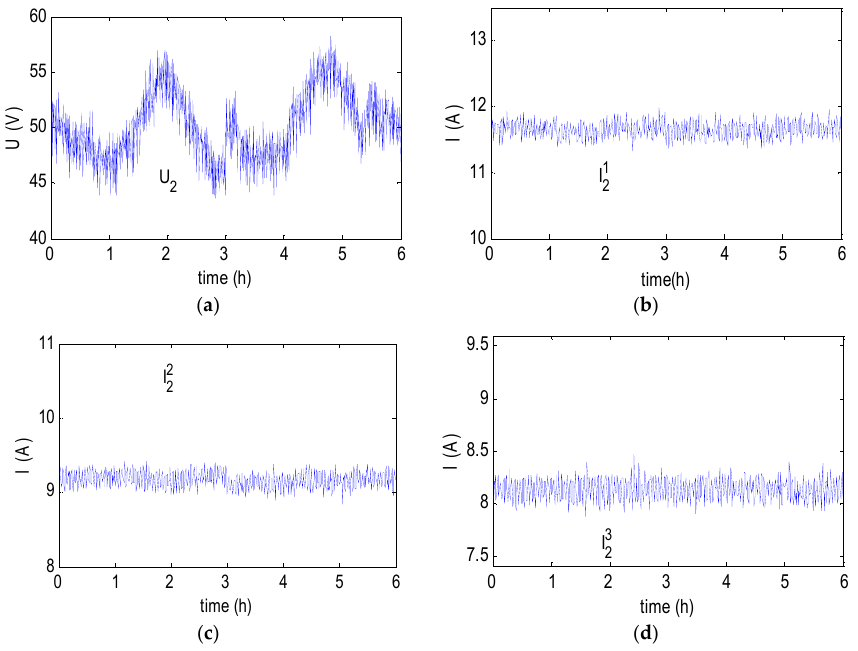
Figure 8. Root mean square (RMS) variation for the negative sequence voltage and feeder current. ( a ): The negative sequence votlage for the measured bus; ( b ): the negative sequence current for feeder